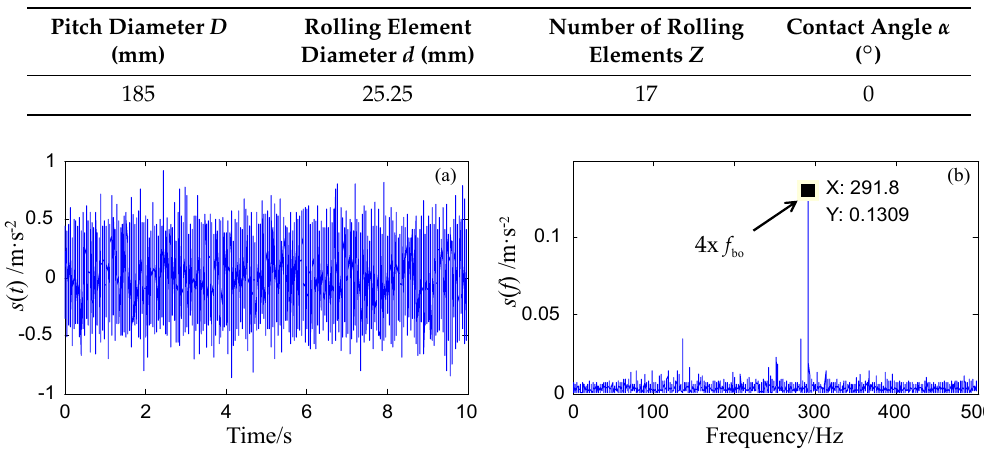
Table 1. The main information on the tested rolling bearing.